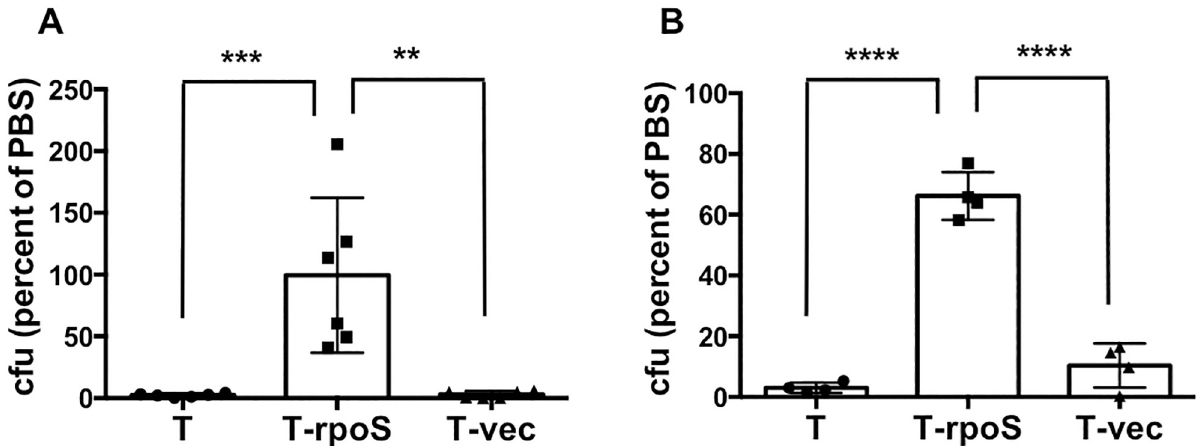
Fig 6. Wild-type rpoS confers resistance to water in Ty2. Equivalent numbers of the parental Ty2 (T), Ty2 transformed with wild-type rpoS (T-rpoS) and Ty2 transformed with empty vector (T-vec), grown overnight in shaking cultures, were incubated in PBS or in sterile distilled water for 1 hour on ice ( A ) or at 37˚C ( B ). The number of bacteria surviving in water was expressed as a percentage of the number in PBS for each strain (the values for PBS are not shown for ease of visualization). A , �� p = 0.0007, ��� p = 0.0006, n = 6 per group. B , ���� p < 0.0001, n = 4 per group.